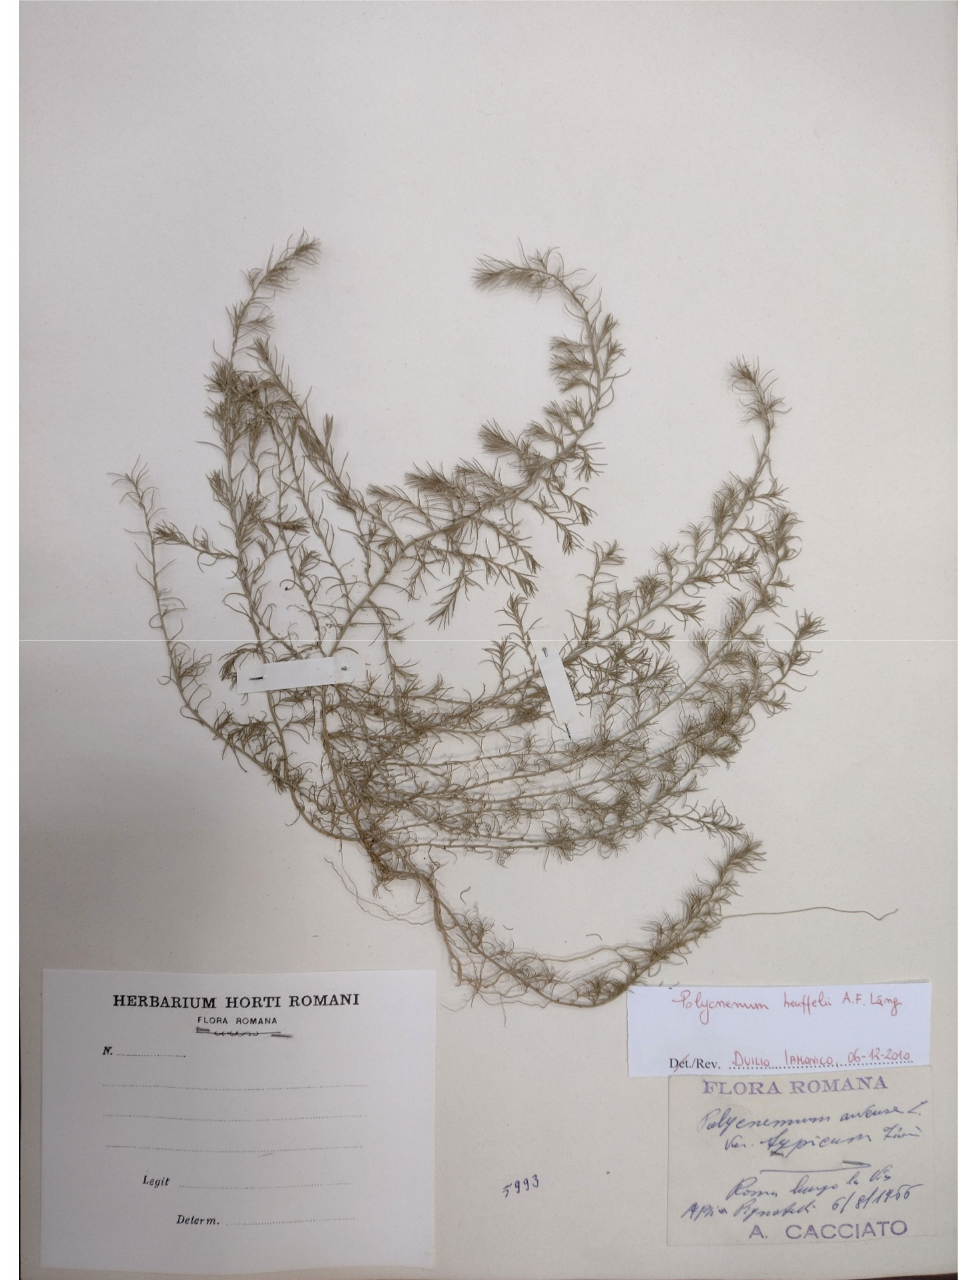
Figure 67. Specimen of Polycnemum heuffelii collected along Appia Pignatelli street in august 1966 (RO-Herbarium Romano no.